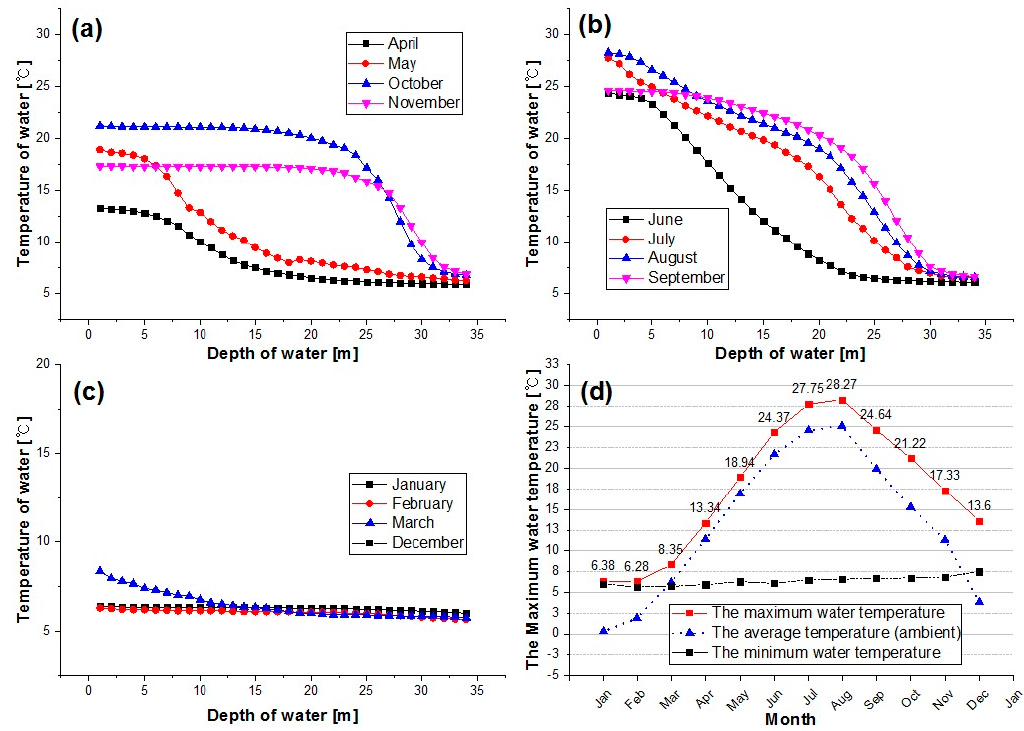
Figure 3. Seasonal water temperature against water depth at Hapcheon Dam ( a ) in spring and fall; ( b ) in summer; ( c ) in winter; and ( d ) monthly water temperature and average temperature.